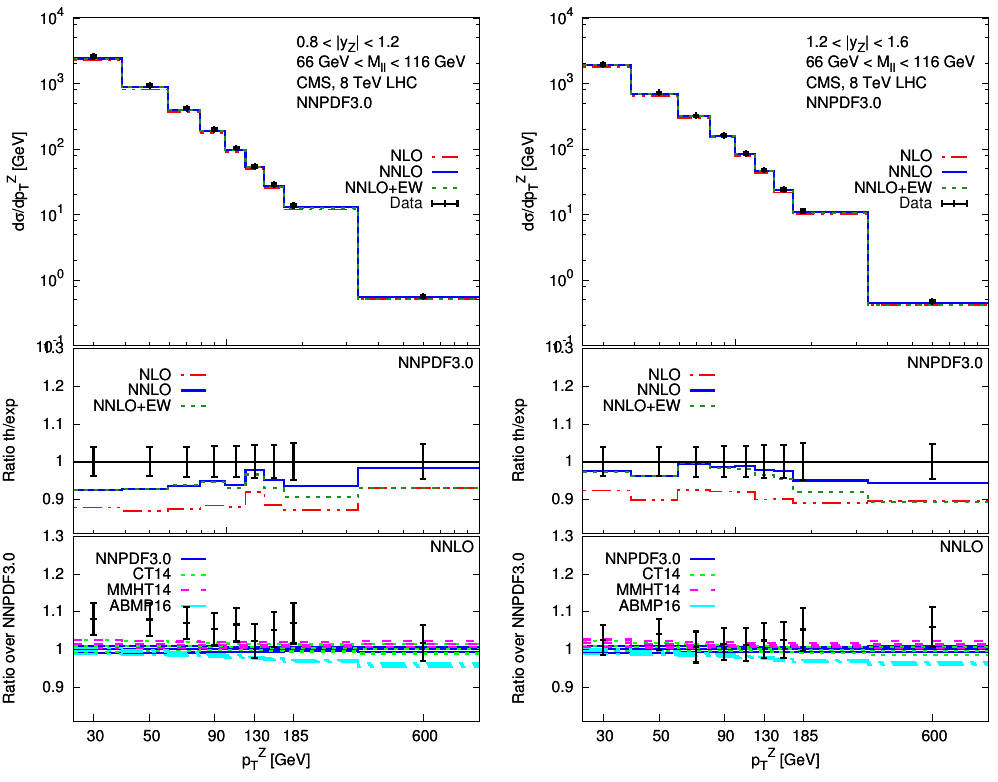
Figure 7 . Same as (cid:12)gure 6 for two higher rapidity